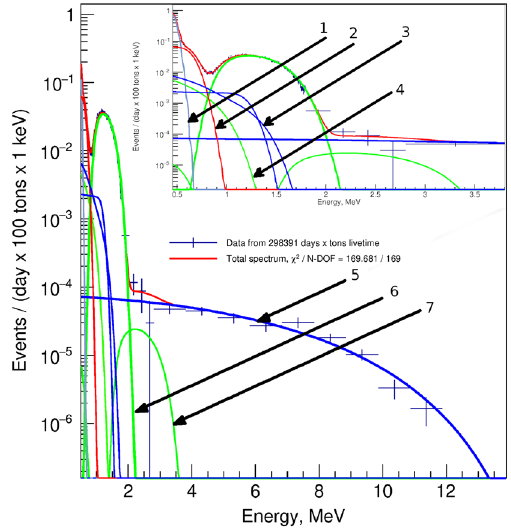
Fig. 4 SpectralfitoftheselectedBorexinodataafterstatisticalsubtrac- tion of external backgrounds. The spectral components considered are: 1 – 210 Po α -peak, 2 – recoiled electrons from the solar 7 Be, 3– recoiled electrons from the solar CNO and pep -neutrinos, 4 – 210 Bi β -spectrum, 5 – solar 8 B neutrino electron recoils, 6 – 11 C β + -decay, 7 – 10 C β + - decay. The inset shows the data in the energy range [0.5–4] MeV. The fit shows a good statistical agreement with this spectral composition model and with the fluxes that are in agreement with [24,40]